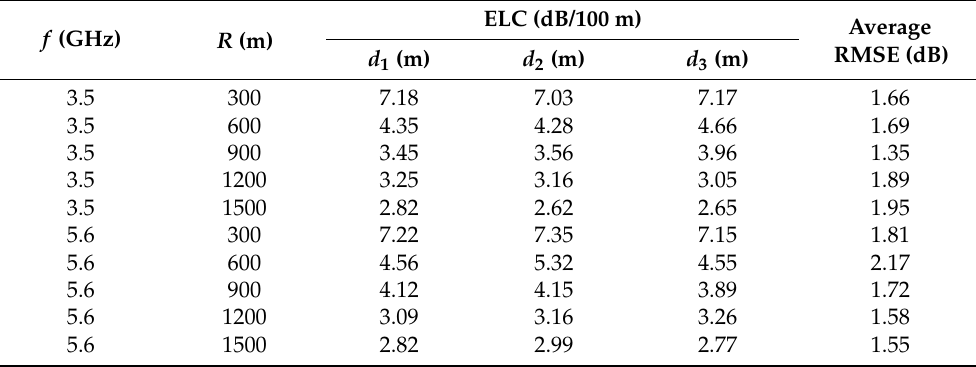
Table 5. ELC and average RMSE for different radii of